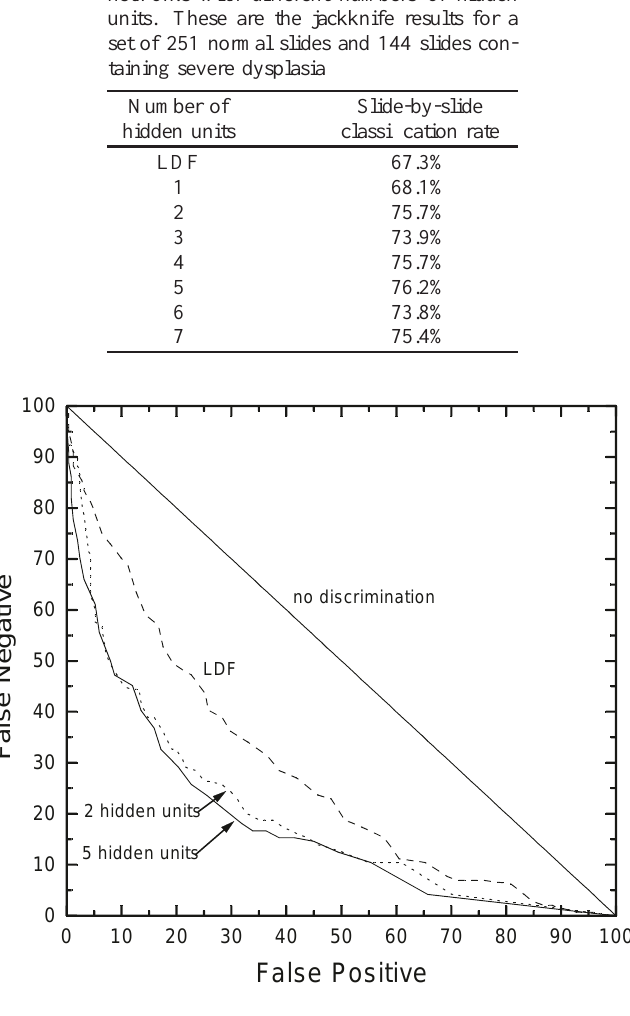
Fig. 3. The slide-by-slide ROC curves for the LDF and networks giving the best test set classification rate are shown. The ROC curves for the best networks using three, four, six and seven hidden units nearly coincide with those of the networks with two and five hidden units and are not